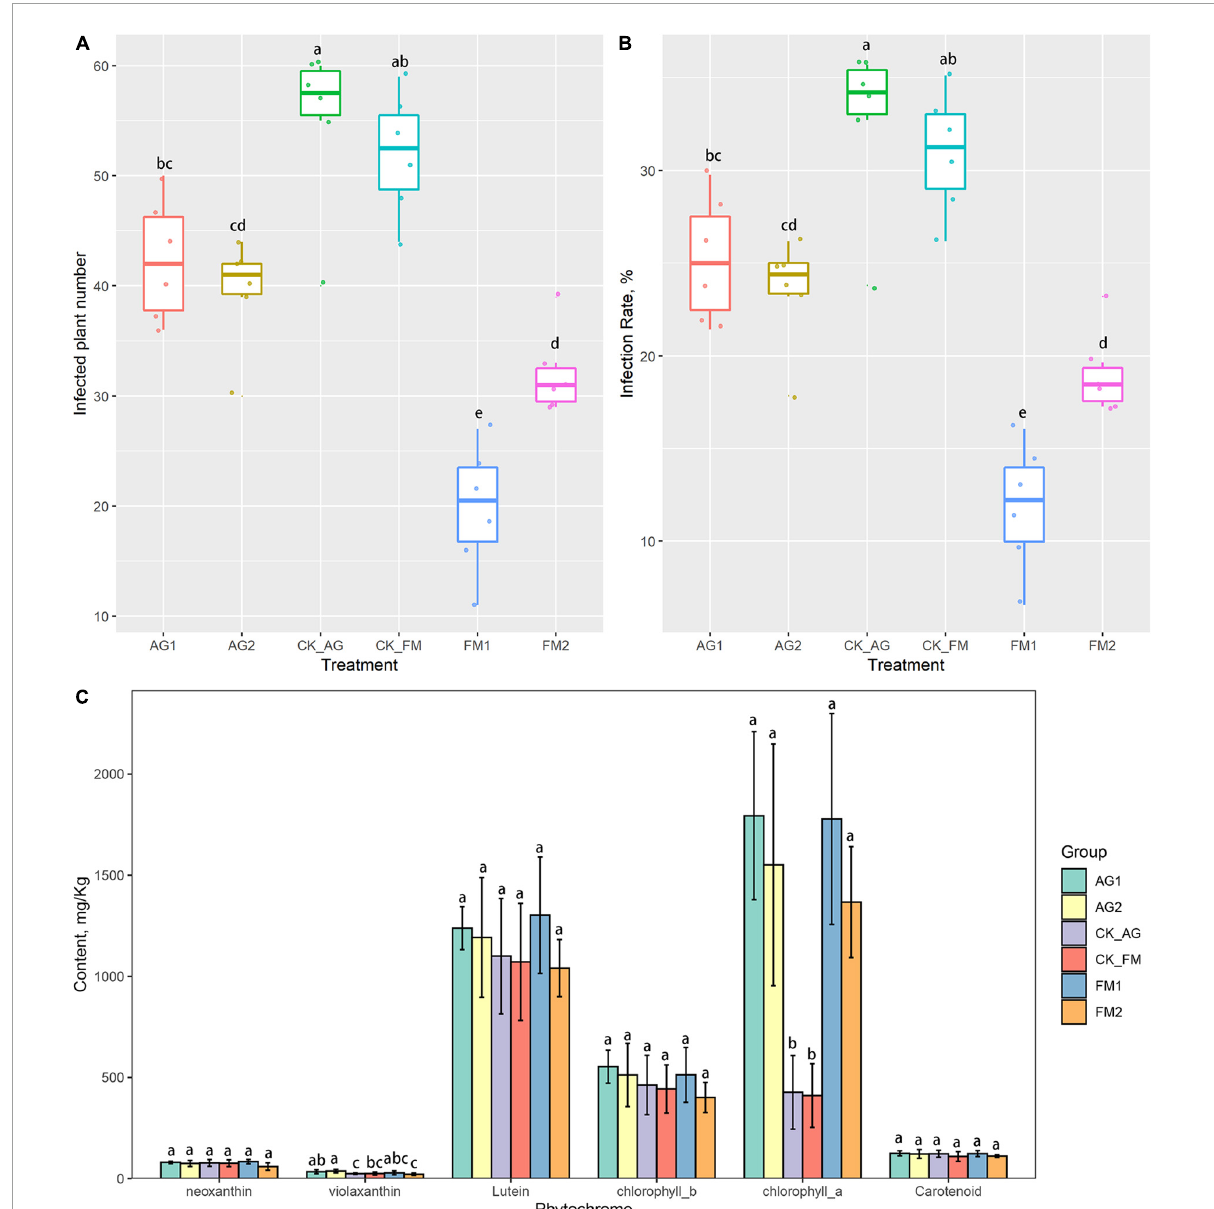
FIGURE1 Plant soil-borne disease infection, (A) infected plant numbers and (B) disease infection rate, and plant phytochrome content in leaves (C) . Results are means and SD of six replicated plots; different letters above the columns indicate the differences are significant at p < 0.05